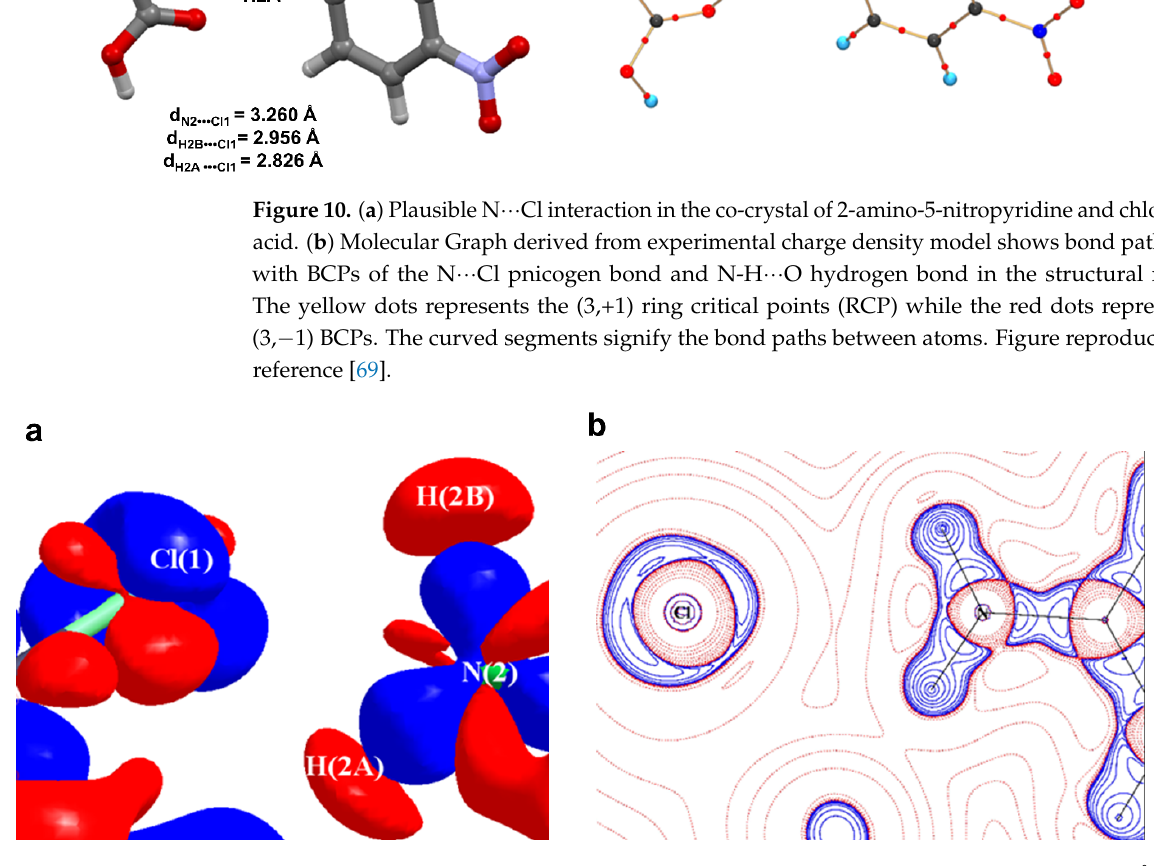
Figure 11. ( a ) The 3D static deformation density map drawn on isosurface of ± 0.08 eÅ-3. Blue re- gions indicate the charge concentration regions, while red regions indicate charge-depleted regions; ( b ) 2D plot of Laplacian map drawn at logarithmic scale. Blue solid lines and red dots represent positive and negative contours, respectively. (Figure reproduced from reference [69] ).